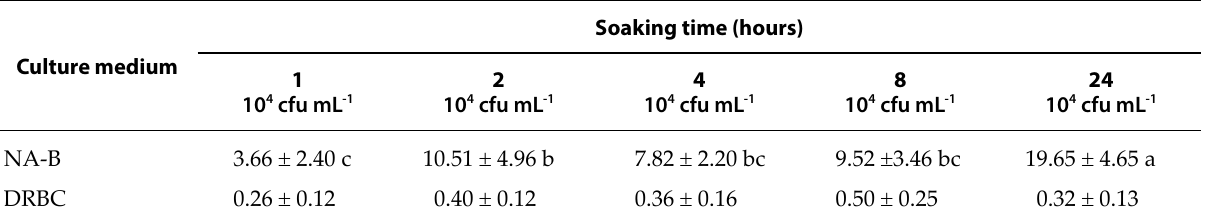
Table 2. Colony forming units (cfu) of bacteria and fungi isolated from soaking water of Shiraz cuttings.